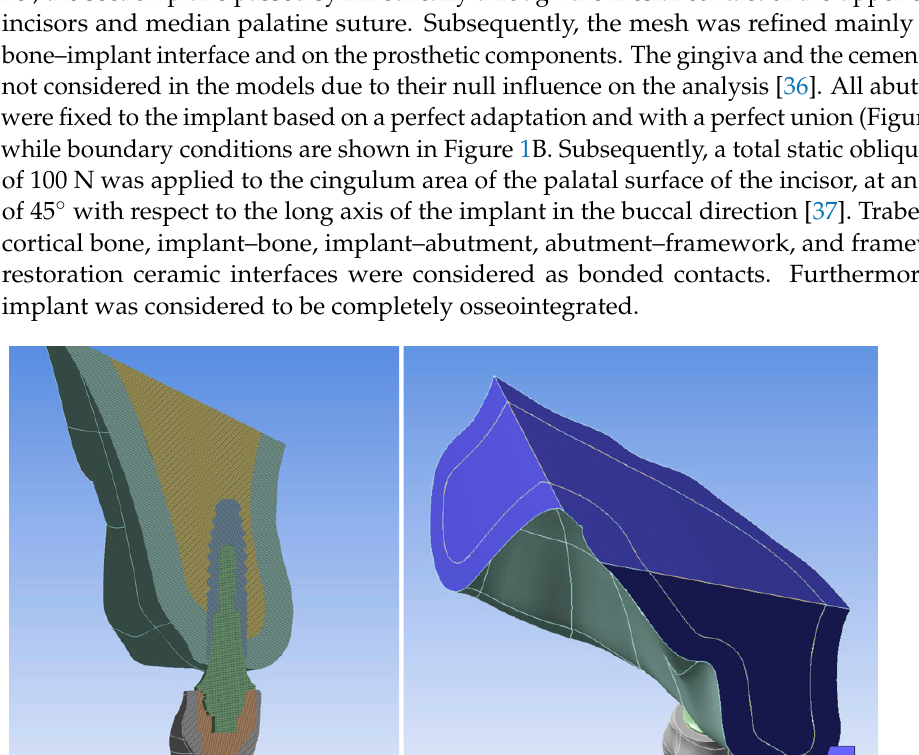
of bone overload [38].